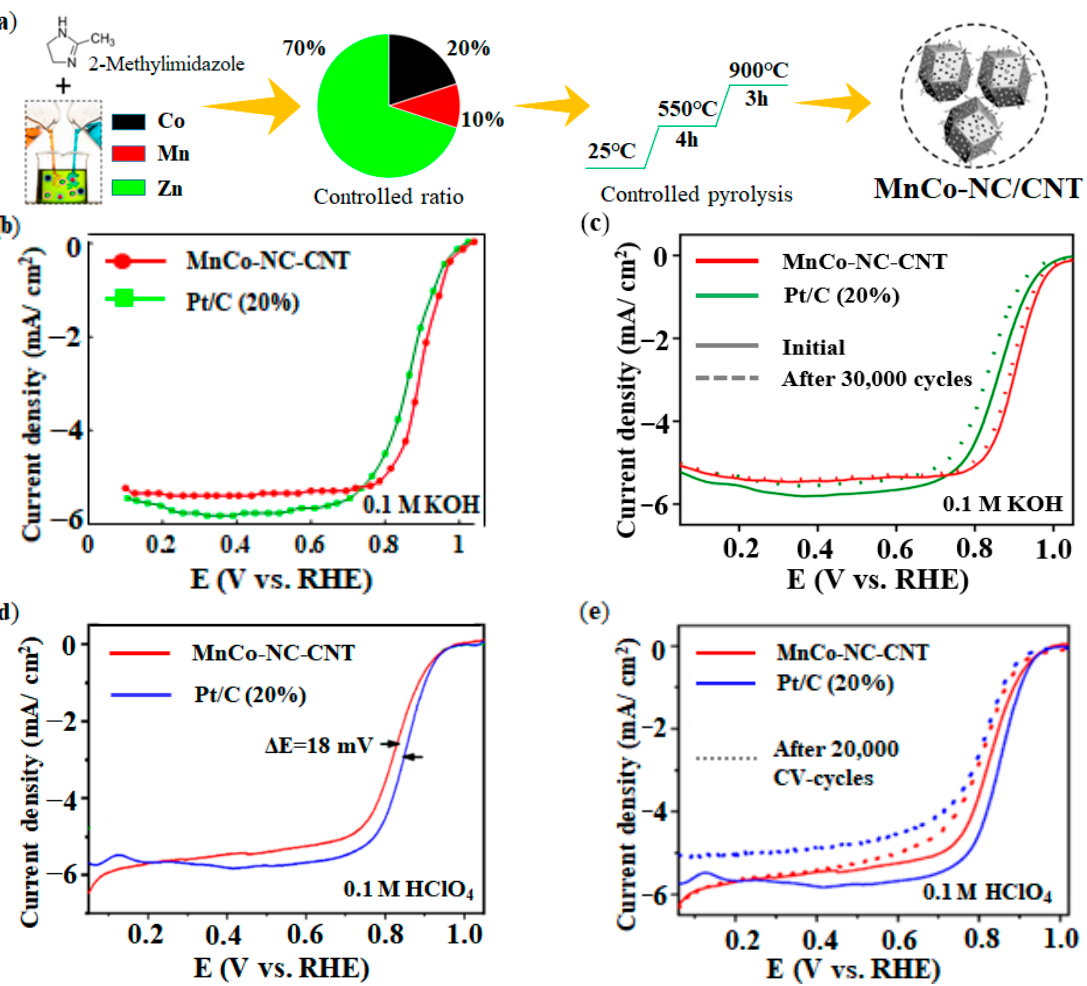
Figure 13. Synthesis method and performance of MnCo-NC/CNT catalyst: ( a ) Synthesis procedure of MnCo-NC/CNT catalyst; ( b ) ORR activity in 0.1 M KOH; ( c ) ORR durability in 0.1 M KOH; ( d ) ORR activity in 0.1 M HClO 4 ; ( e ) ORR durability in 0.1 M HClO 4 . Adapted with permission from Ref. [139]. Copyright 2021 American Chemical Society.